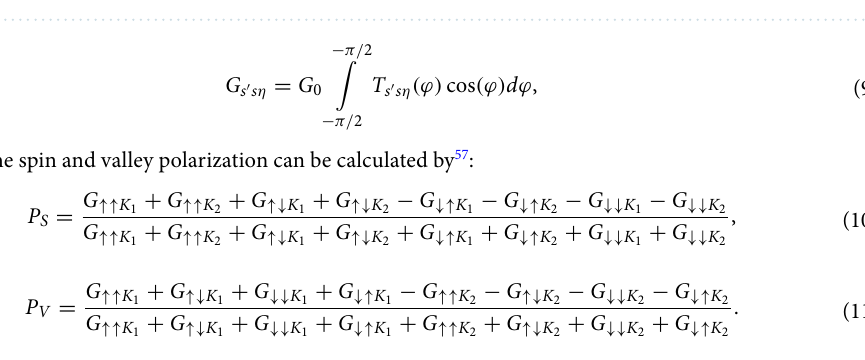
Figure 3. The spin dependent conductance for valley K 2 versus ε , for fixed E = 1.5 (cid:31) , U 0 = 3.5 (cid:31) , (cid:31) R = 50 meV, k F b = 5 and k F w = 3. For ( a ) two barrier, ( b ) four barriers, and ( c ) eight barriers 0 0